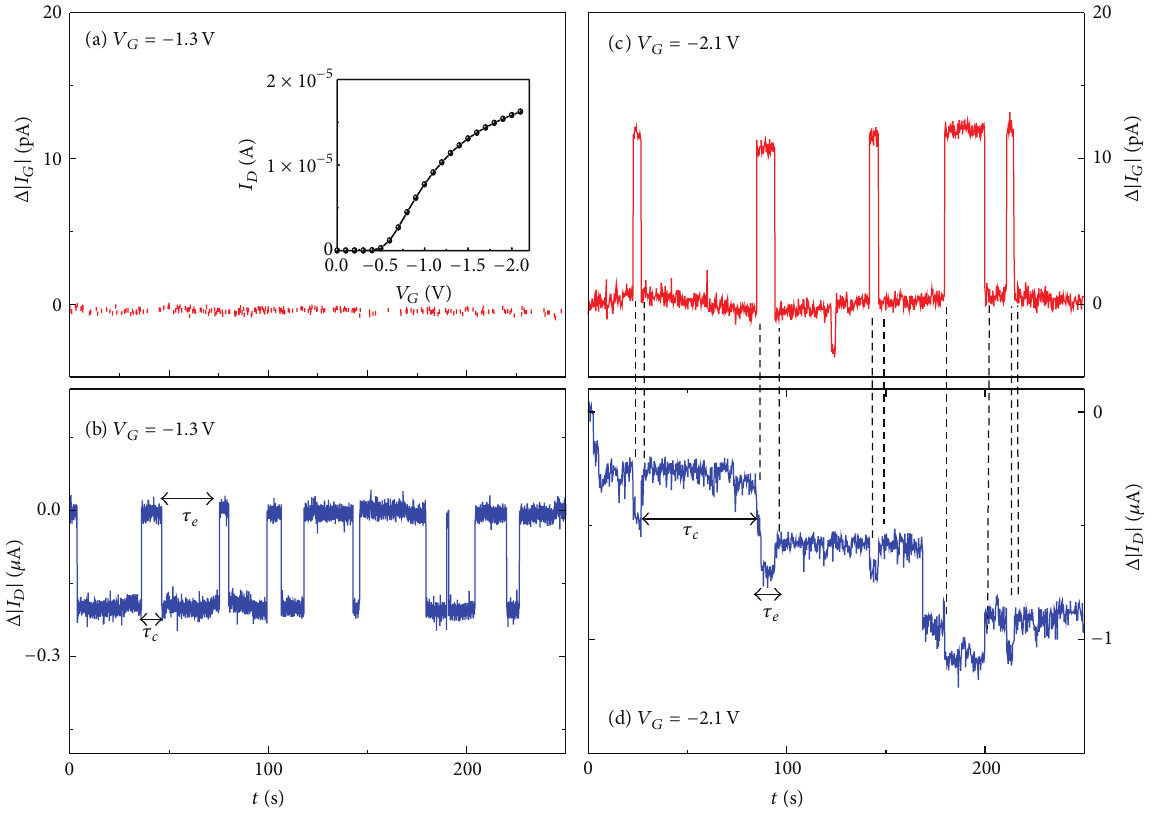
Figure 1: The time trace of 𝐼 𝐺 and 𝐼 𝐷 fluctuation under the gate voltage 𝑉 𝐺 of − 1.3V and − 1.9V with 𝑉 curve of the experimental device.